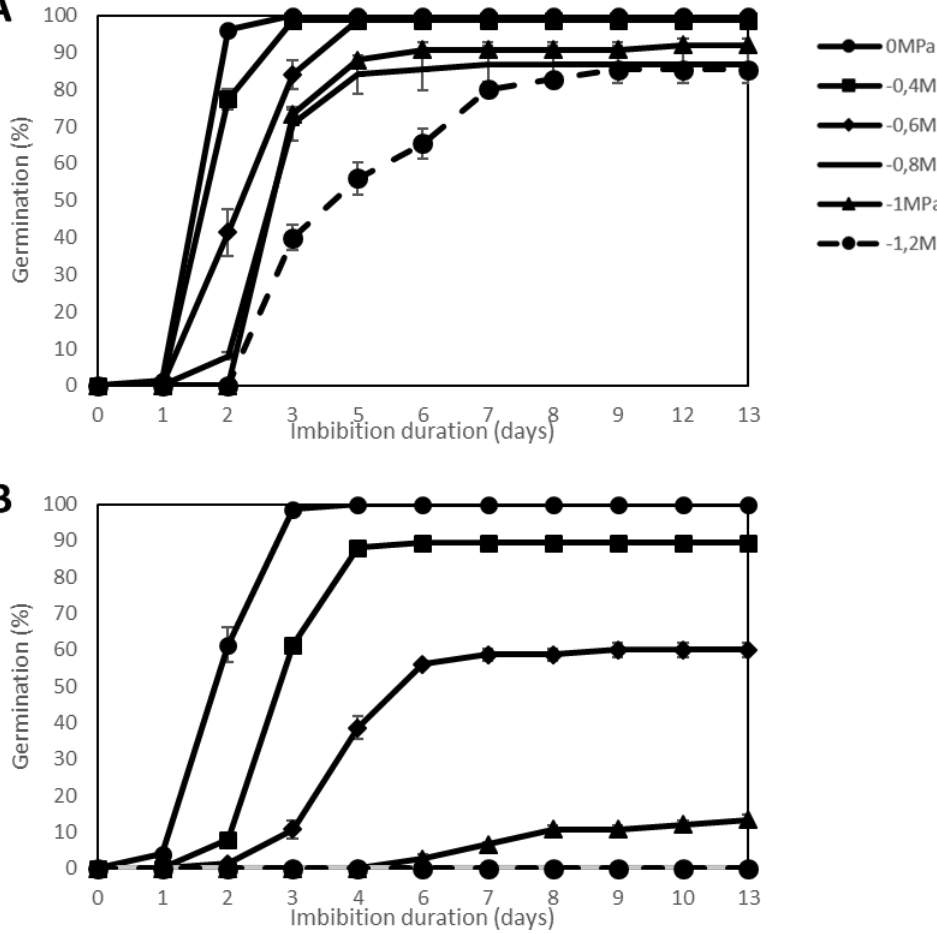
Figure 1. Germination curves of 2 sunflower genotypes, Helianthus annuus sp. SOLQUA-160 ( A ) and SOLQUA-165 ( B ) Water stress ( − 0.4 MPa; − 0.6 MPa; − 0.8 MPa; − 1 MPa; − 1.2 MPa) was applied during germination at 20 °C in comparison to the control on water (0 MPa).